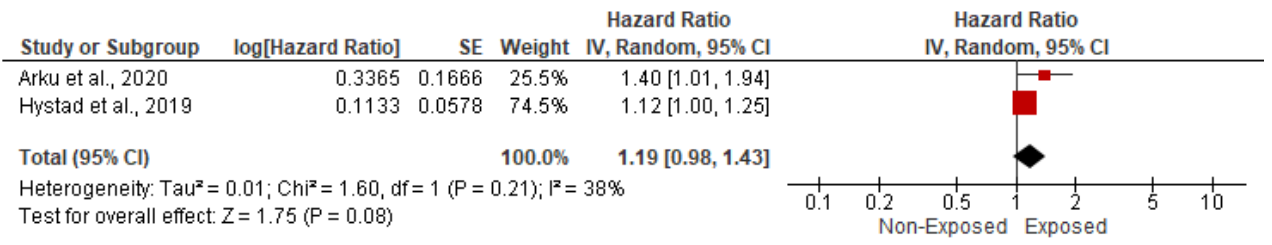
Figure 10. Forest plot of summary analysis of the hazard ratio and 95% CI of the association between HAP and myocardial infarction risk. The size of the red squares is proportional to the statistical weight of each trial. The gray diamond represents the pooled point estimate. The positioning of both diamonds and squares (along with 95% CIs) beyond the vertical line (unit value) suggests a significant outcome (IV = inverse variance).